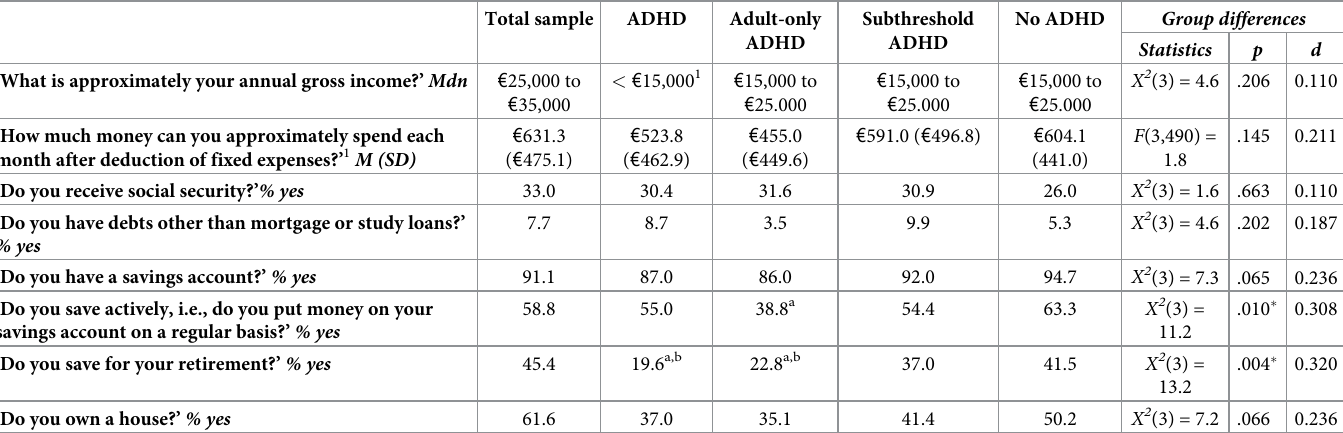
Table 3. Personal financial situation of the total sample and ADHD